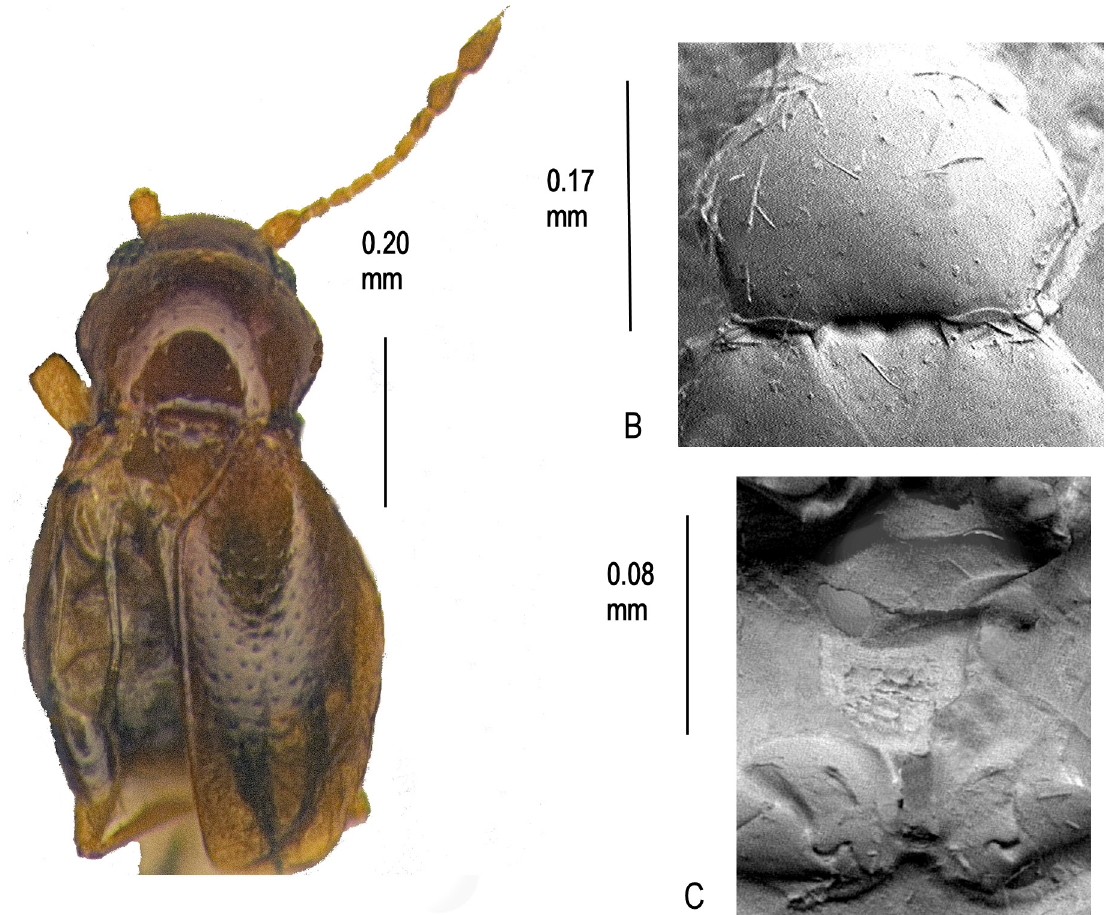
Fig. 98 . Cissidium obsoletum sp. nov. A . Habitus. B . Pronotum, × 435. C . Mesoventrite showing median process of collar, mid-keel and keel, ×